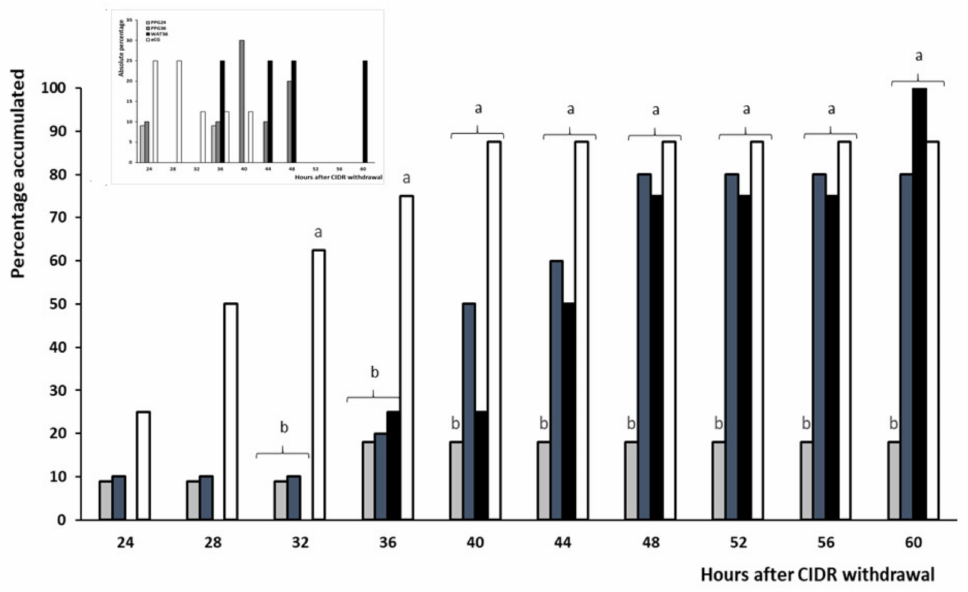
Figure 5. Timing of onset of estrus in ewes treated with one CIDR with PGF 2 α and 400 IU of eCG (at CIDR removal; group eCG, white bars) or 50 µ g of GnRH in either distilled water (56 h after CIDR removal; group WAT56, black bars) or propylene-glycol (24 or 36 h after CIDR removal; groups PPG24 and PPG36, with light and dark grey bars, respectively). Cumulative percentage of animals is represented in the main panel, whereas absolute percentages in each interlude are represented in the inset graph. Di ff erent letters indicate statistical di ff erences between groups (a (cid:44) b: p <